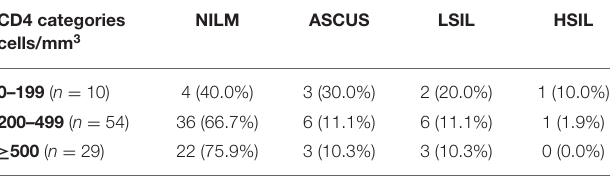
TABLE 4 | Distribution of Pap categories in CD4 categories ( n = 87).